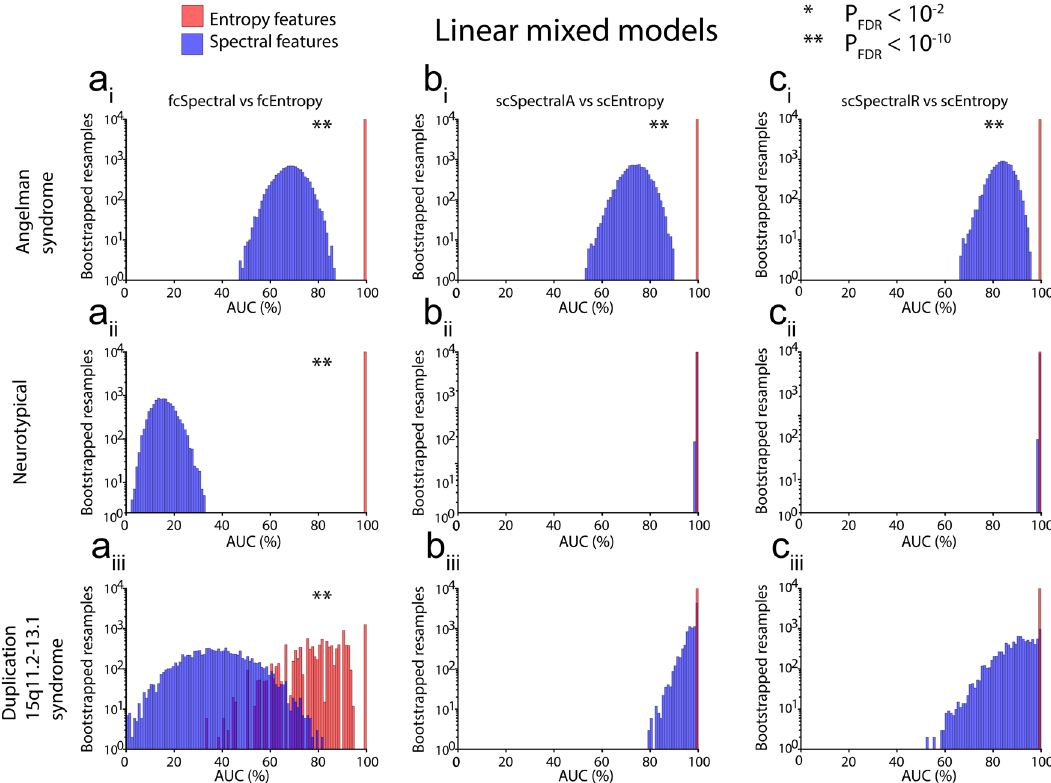
Fig. 6 Comparison of areas under the receiver operating characteristics curve (AUCs) for entropy (red) and spectral (blue) features selected using linear mixed models (LMMs). As in Fig. 5, we performed three basic comparisons ( a fcEntropy vs fcSpectral; b scEntropy vs scSpectralA; c scEntropy vs scSpectralR) with EEG data from three datasets [AS (top row) training data; NT (middle row) validation data; Dup15q (bottom row) validation data]. In each case, we generated 10,000 bootstrapped resamples to derive AUC con fi dence intervals in Supplementary Table 3. Note that the number of resamples on the vertical axis of each histogram is log-scaled due to the very large range of resamples across histogram bins. Also note that classi fi er performance was saturated using entropy features for all comparisons except for a iii (Dup15q FC features), i.e., all bootstrapped resamples yielded 100% AUC for entropy features in these instances. Five out of the nine comparisons above yield signi fi cantly larger AUCs for entropy features, as indicated by asterisks. Source data are presented in Supplementary Data 5.